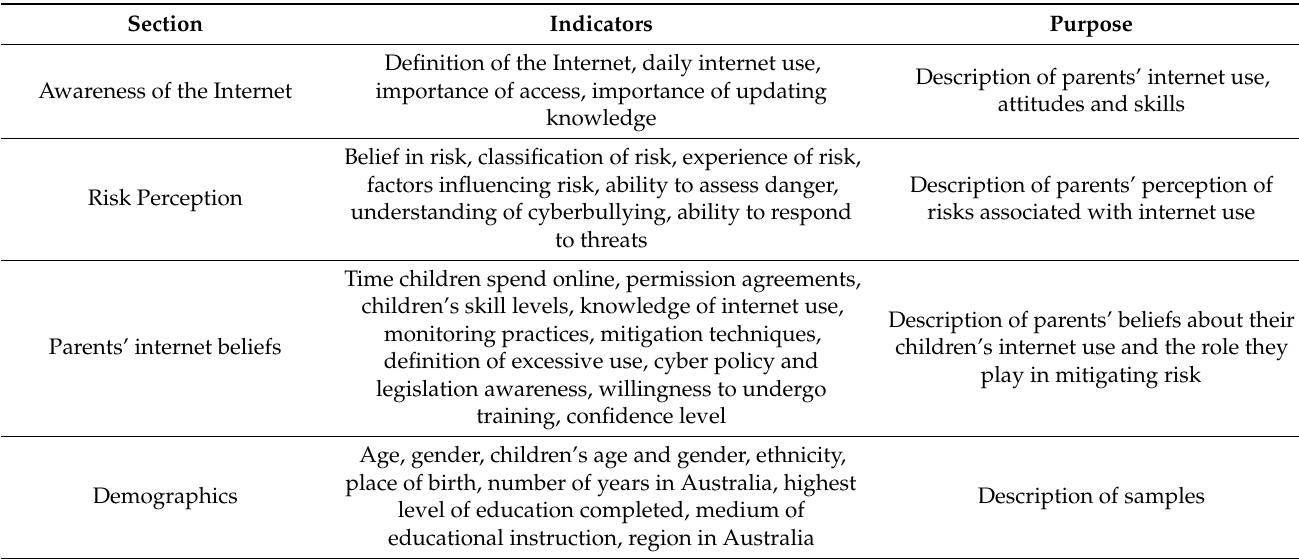
Table 1. Survey questionnaire